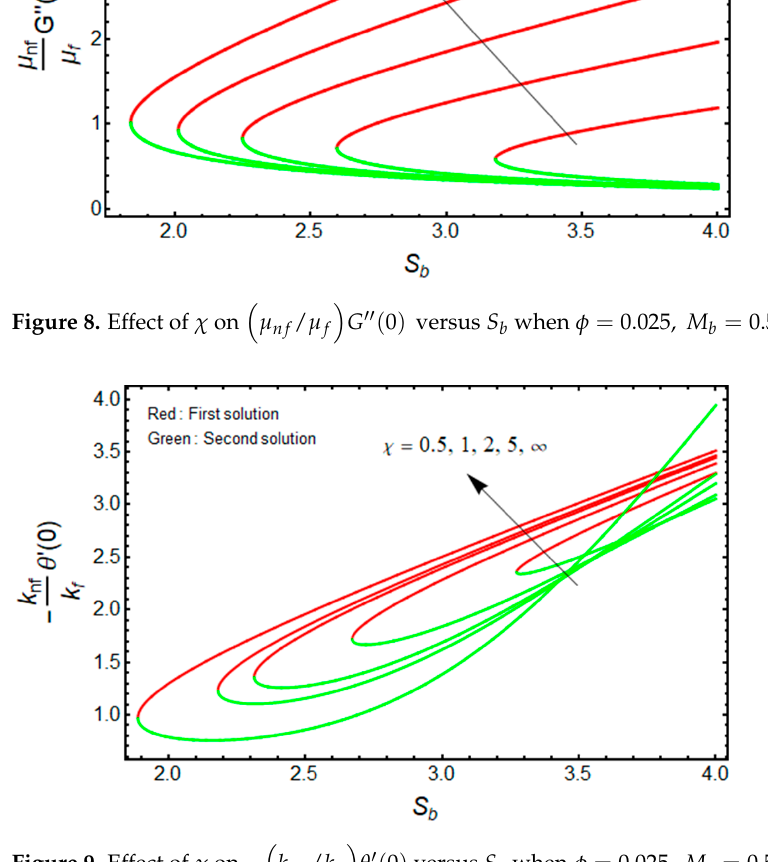
Figure 9. Effect of χ on −